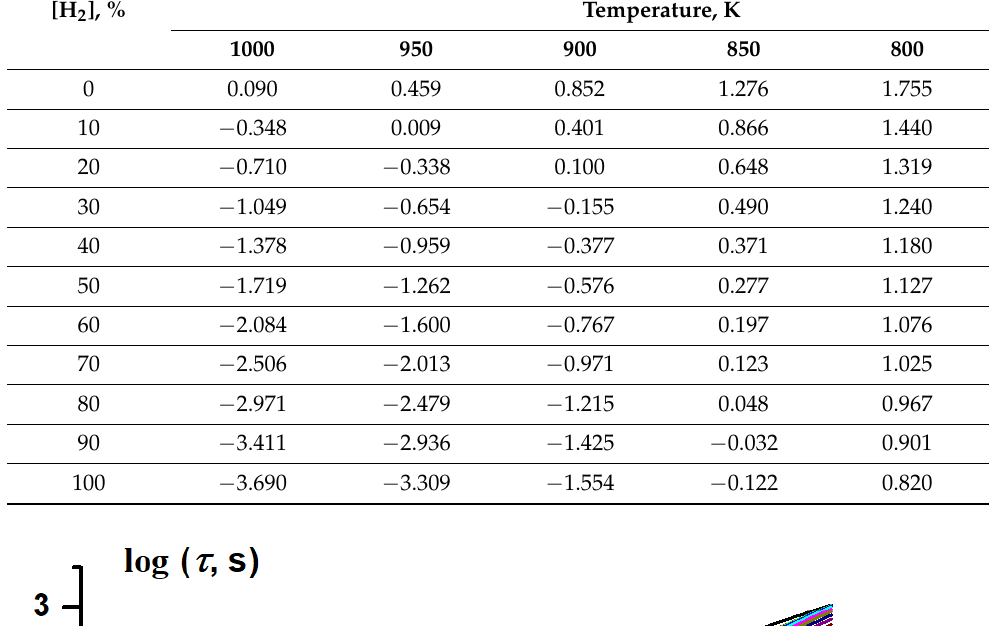
Table 1. Calculated autoignition delay time lg